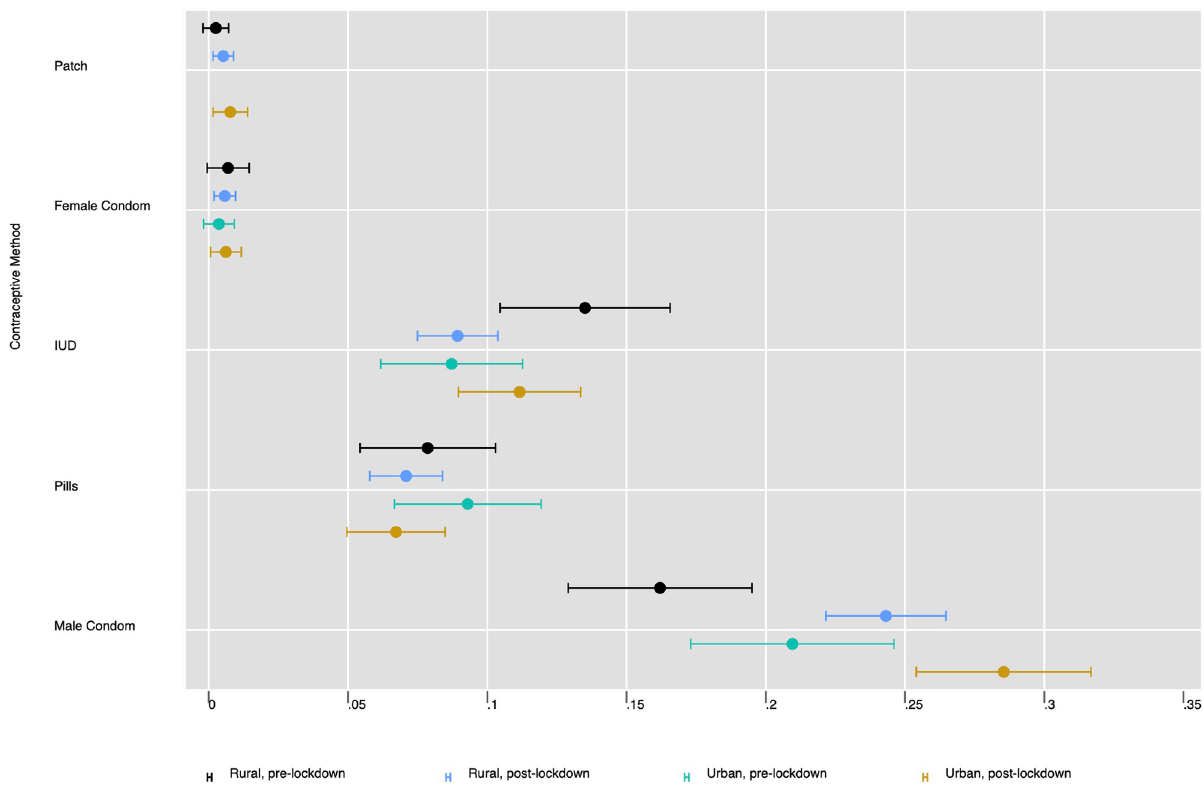
Fig 4. Marginal effects at the mean of contraceptive use pre and post